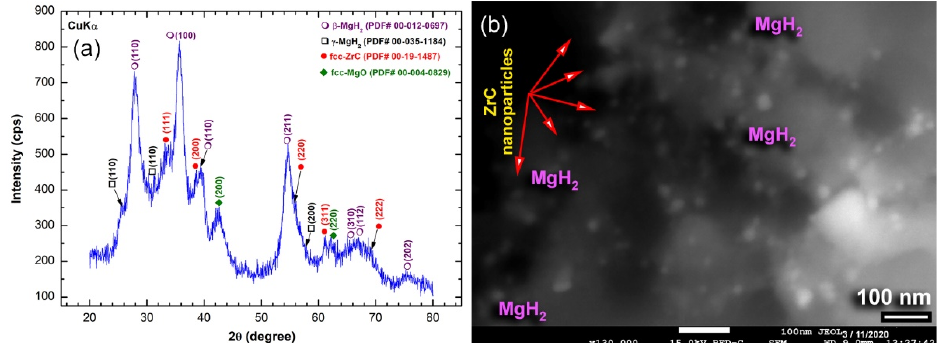
Figure 5. ( a ) XRD pattern and ( b ) back-scattering electron FE-SEM micrograph of mechanically mixed MgH 2 /5 wt.% ZrC nanocomposite powders obtained after 50 h of HEBM. The nanodispersoid ZrC, which are indexed by the red arrow labels in ( b ), were embedded into the MgH 2 powder matrix.